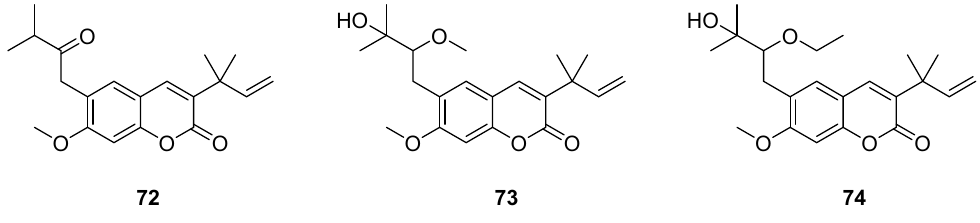
Figure 28. Prenylated coumarins from Manilkara zapota .